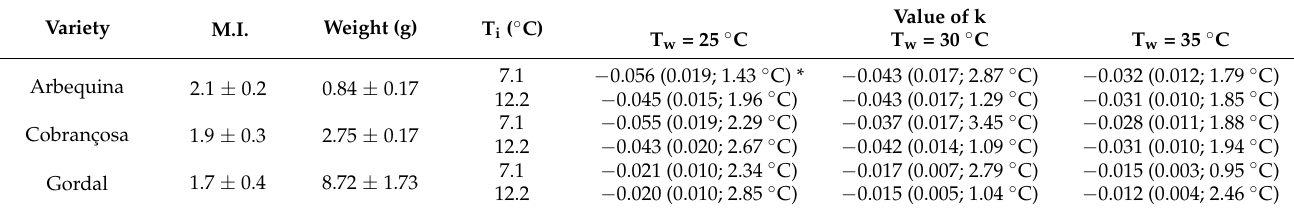
Table 1. Maturity index (M.I.), weight, and proportionality constant (k) empirically calculated for different varieties, at two different initial temperatures (T i ) and after being submerged in water at different temperatures.